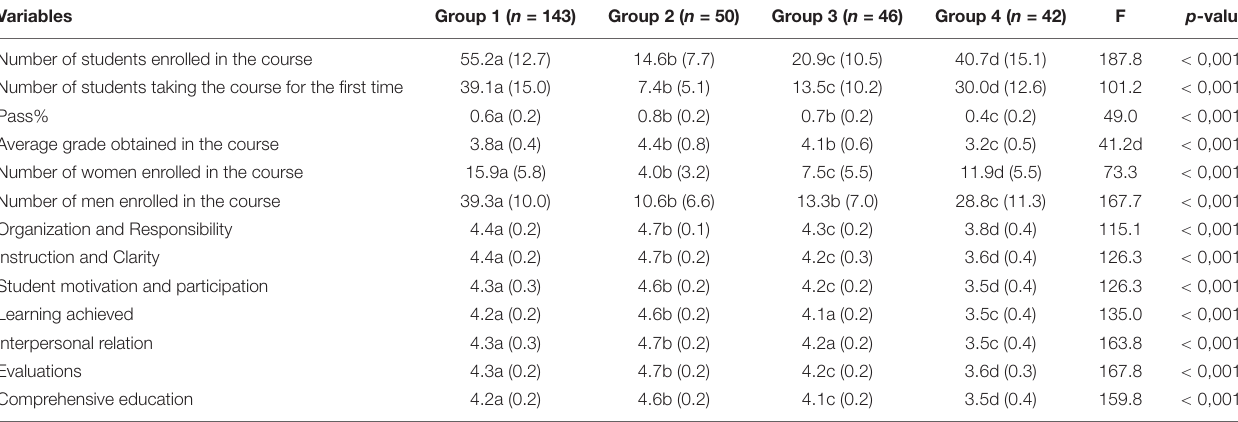
TABLE 1 | Mean scores (SD) of the variables by groups obtained by hierarchical cluster analysis.